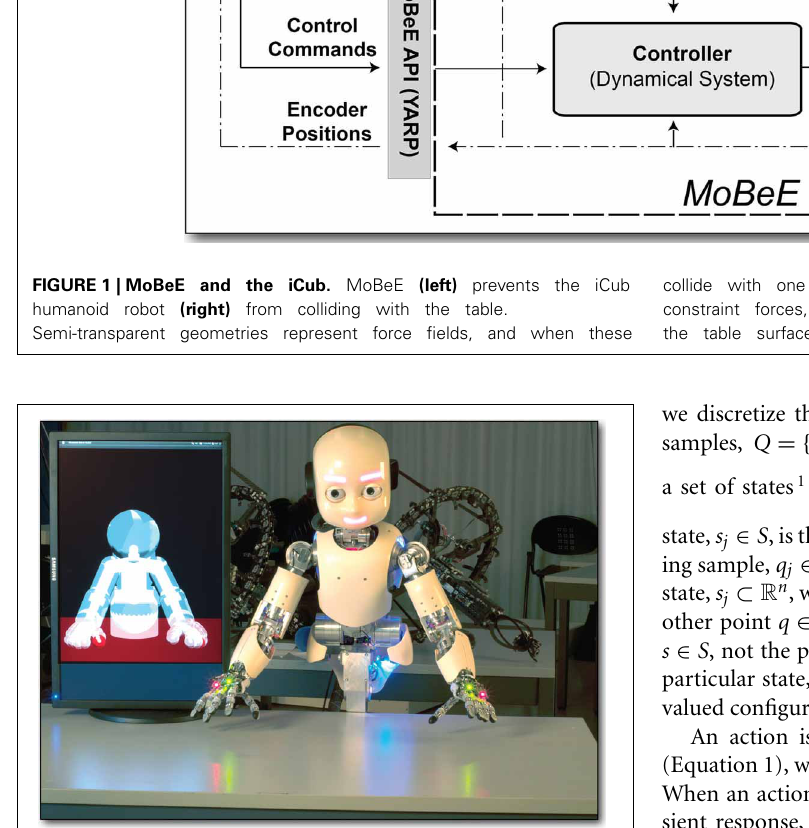
FIGURE 2 | The modular behavioral environment (MoBeE) architecture. MoBeE implements low-level control and enforces all necessary constraints to keep the robot safe and operational in real time, such that the curious RL agent (left) is able to experiment with arbitrary control commands. A kinematic/geometric model of the iCub humanoid robot (top) is driven by streaming motor encoder positions from the hardware (right) . The model computes fictitious constraint forces, which repel the robot from collisions, joint limits, and other infeasibilities. These forces, f i ( t ) in Equation (1) , are passed to the controller (middle) , which computes the attractor dynamics that governs the actual movement of the